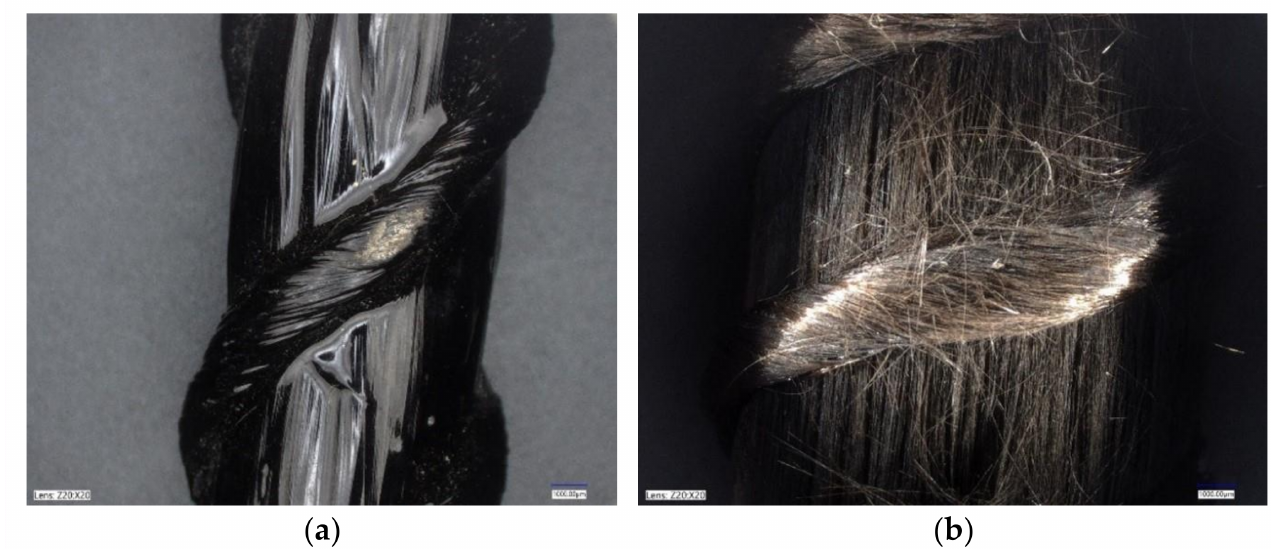
Figure 6. Magnified images of HFRP bars (20 × 20): ( a ) before testing; ( b ) after testing. As the sample bars were uncovered from the destroyed elements, it was observed that in the middle part of the beam (where the temperature was applied), the bars were able to be removed easily, in contrast with the side parts. Figure 7a shows that once the glass transition temperature was reached, the matrix evaporated and the contact with the concrete was lost. Consequently, as shown in Figure 7b, the beam side parts were considered as anchors for tested samples.